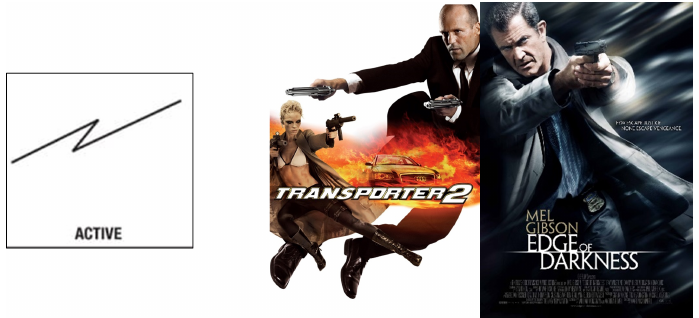
Figure 6. Example of the application of mood lines on movie posters